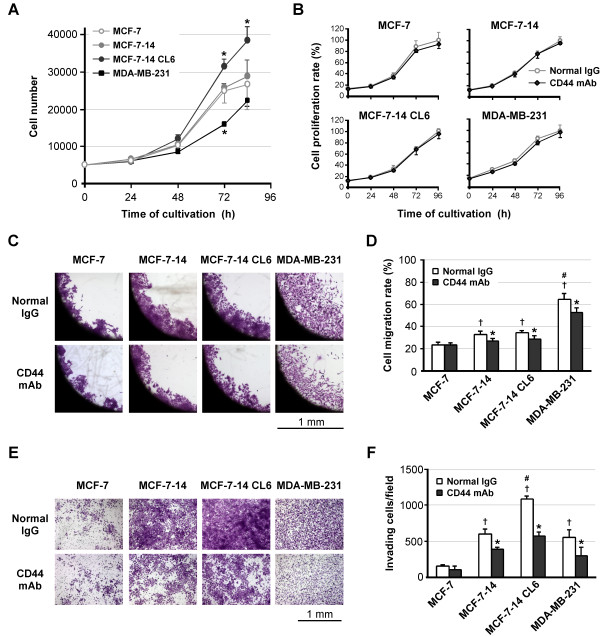
Effects of anti-CD44 antibody treatment on cell proliferation, migration and invasion. (A) Proliferation rates of untreated cells in culture. Data are the means ± SD (n = 3). Statistical analysis was performed by ANOVA and Tukey-Kramer multiple comparison. *, P < 0.01, compared with MCF-7 cells. (B) Proliferation rates of normal rat IgG-treated and anti-CD44 antibody-treated cells. In each cell line, the number of normal IgG-treated cells at 96 h was considered 100%. Data are the means ± SD (n = 3). (C) Optical microscopic images of cell migration assay at 72 h after removal of the stopper. Cells were fixed and stained with crystal violet. (D) Cell migration rates were expressed as percent closure of the open area by comparing the zero time. Data are the means ± SD (n = 6). Statistical analysis was performed by Student's t test or ANOVA/Tukey-Kramer multiple comparison, where appropriate. *, P < 0.01, compared with normal IgG-treated cells.†, P < 0.01, compared with MCF-7.#, P < 0.01, compared with MCF-7-14 and its clone CL6. (E) Matrigel invasion assay of normal rat IgG-treated and anti-CD44 antibody-treated cells. After 60 h cultivation, cells invading Matrigel were fixed and stained on the underside of the chamber. (F) The numbers of invading cells were counted under a microscope. Data are the means ± SD (n = 3). Statistical analysis was performed by Student's t test or ANOVA/Tukey-Kramer multiple comparison, where appropriate. *, P < 0.01, compared with normal IgG-treated cells.†, P < 0.01, compared with MCF-7.#, P < 0.01, compared with MCF-7-14 and MDA-MB-231.